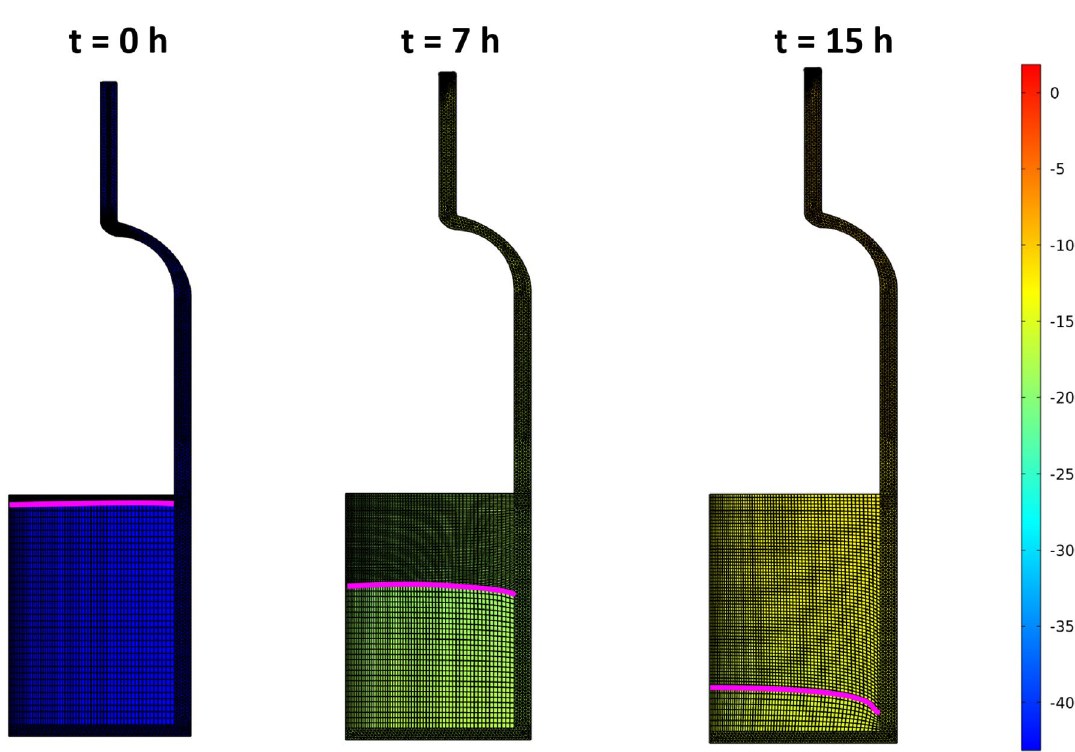
Figure 12. Simulated sublimation front position (purple curve) with computational mesh and temperature fields of the vial and the product for 0, 8 and 15 subject to change from run to run for the same product (such as glass vial properties, material properties (i.e., dried product properties), and ice/vapor characteristics). The second group is the process simulation parameters (Table 3). These parameters are the actual process data, including shelf/air temperatures (measured with con- ventional thermocouples) and chamber pressure (measured with capacitance manometer) which are directly used in the model. The last group, called the tuned process parameters (Table 4), includes parameters that vary from vial to vial (i.e., heat transfer coefficients). They are tuned to match the virtual thermocouple output with the actual data from sensing elements. The vapor viscosity was calculated using the expression derived by Alex- eenko et al. 35 where the experimentally measured 36–39 values and the data from The International Association for the Properties of Water and Steam Formulation 40 were utilized for water vapor viscosity in the range of − 23 ◦ C to 227 ◦ C . The power-law curve fit based on Variable Hard Sphere (VHS) molecular model with an effective diameter of 5.78Å :